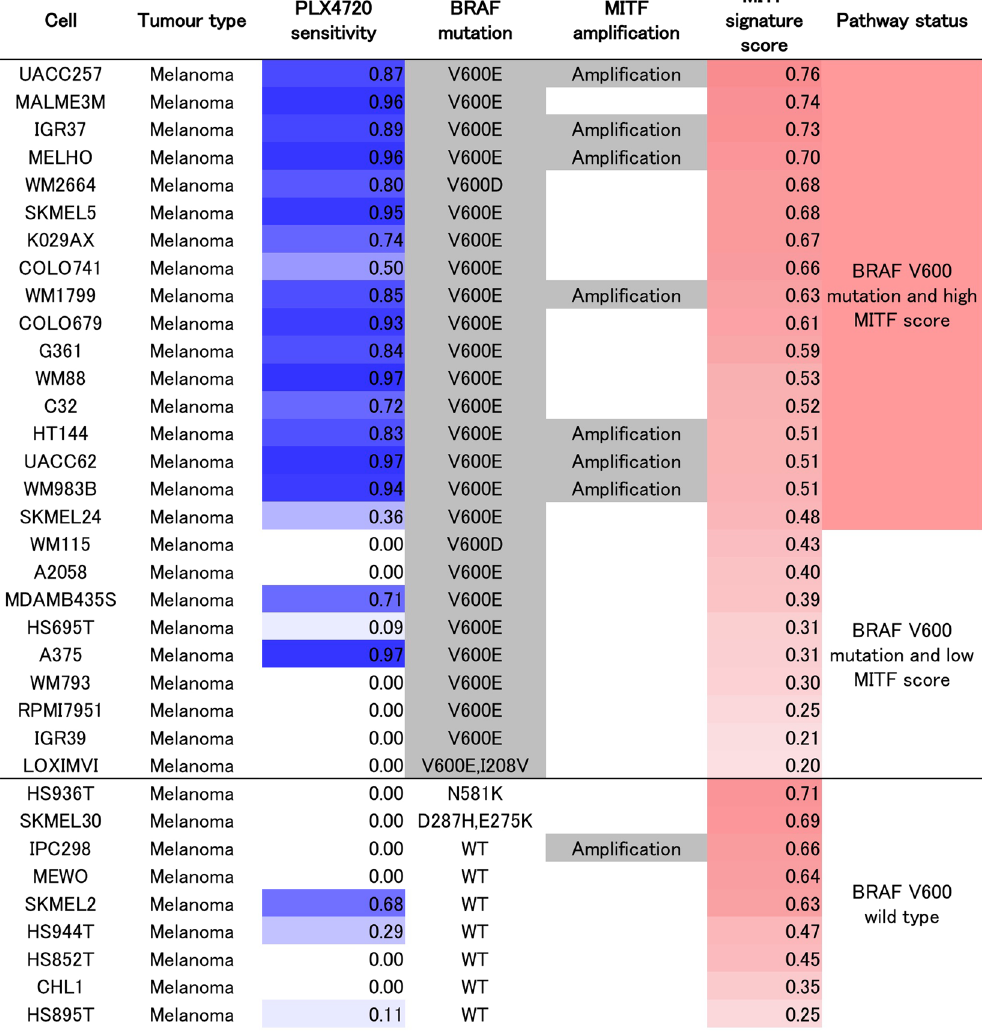
Figure 5. PLX4720 sensitivity profile and alteration of the BRAF/MITF pathway in melanoma cells. The melanoma cells are listed according to their PLX4720 normalized sensitivity profiles (1: sensitive, 0: insensitive), BRAF mutation status as reported in the COSMIC database, MITF copy number amplification as predicted by GISTIC, MITF activation score as obtained from our MITF gene signature, and the three categories classified according to the BRAF V600 mutation status and MITF activation score. Melanoma cells with a BRAF V600 mutated status and a high MITF activation score had higher sensitivity to PLX4720 than cells in the other two categories (Kruskal-Wallis test, p-value <